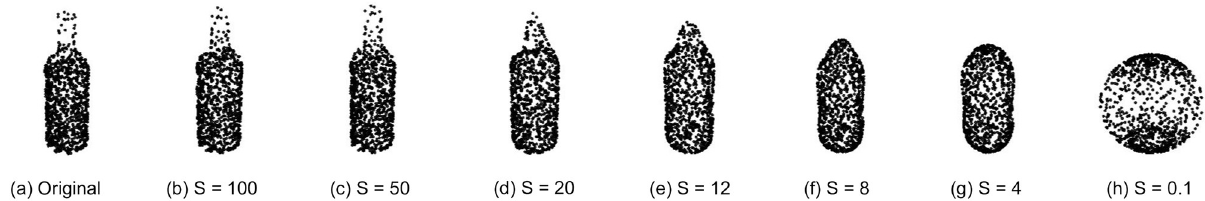
Fig 1. Illustration of a sample point cloud in different frequencies under spherical harmonic transformation. [Lower values of S remove more 3D points with high frequency information, resulting in a more spherical shape.].